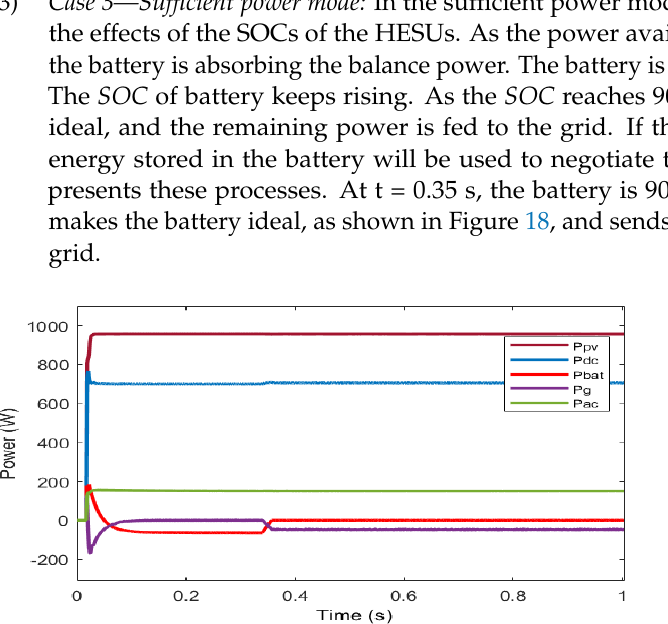
Figure 17. PV, DC load, AC load, grid, and battery power in SPM.